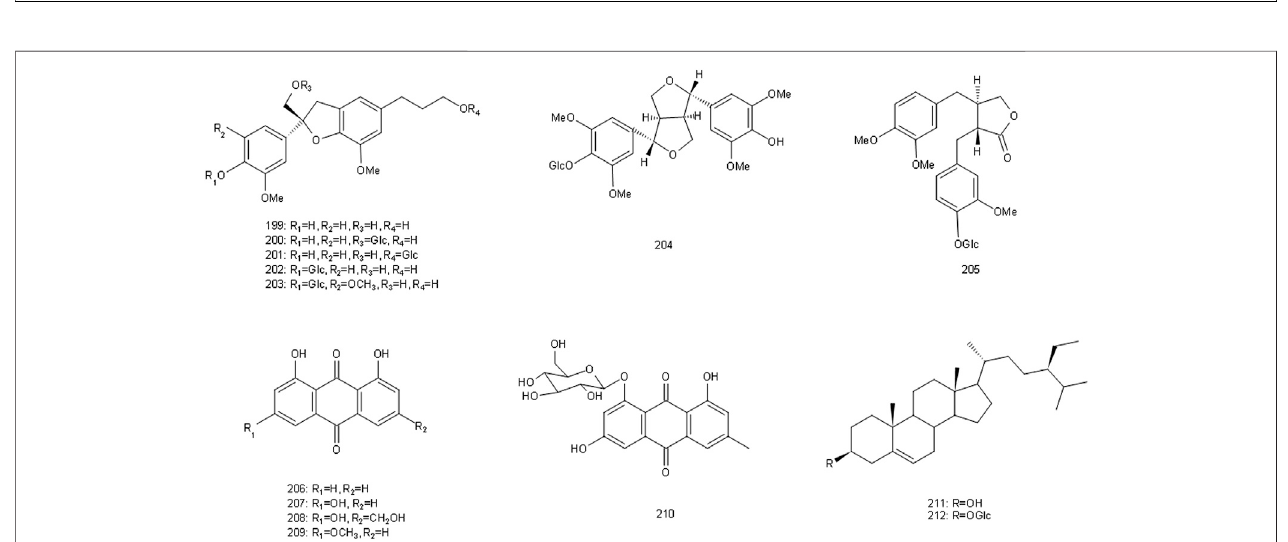
FIGURE 7 | Chemical structures of lignins, anthraquinones and steroids identi fi ed in S. glabra extract.